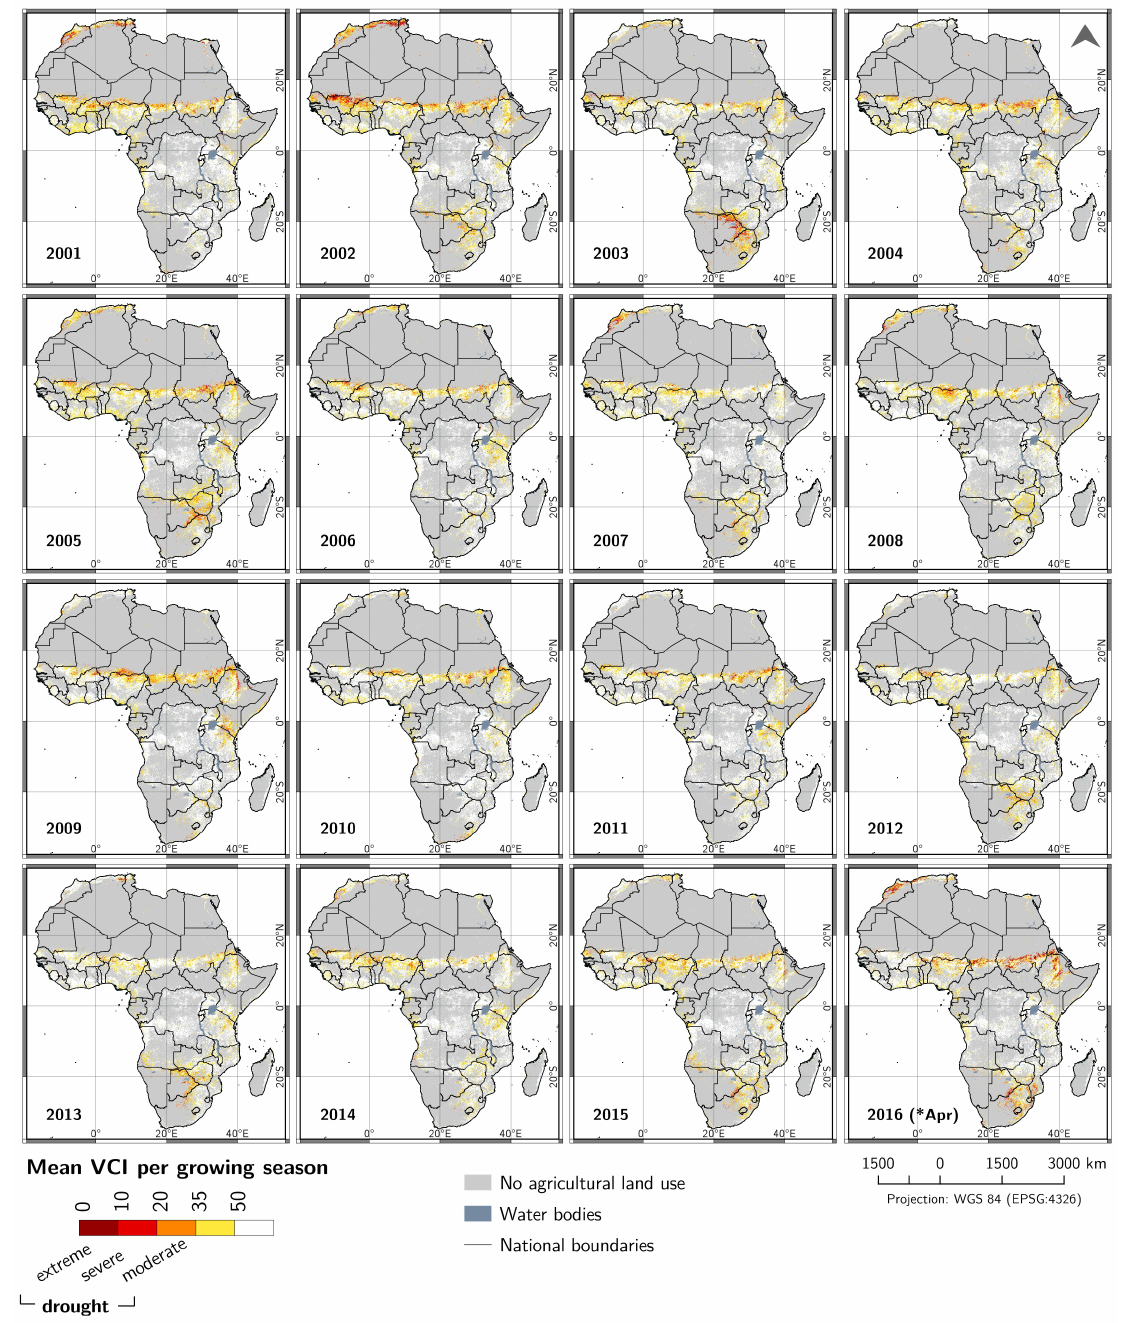
Figure 5. Intensity of drought: Mean VCI per growing season from 2001 to 2016 (seasonal years). The lower the VCI, the more intense is the